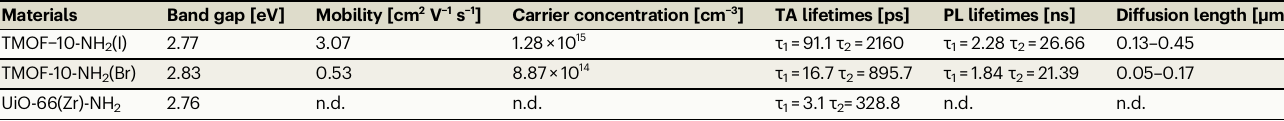
Table 1 | Carrier transport characteristics of TMOF-10-NH 2 and UiO-66(Zr)-NH 2